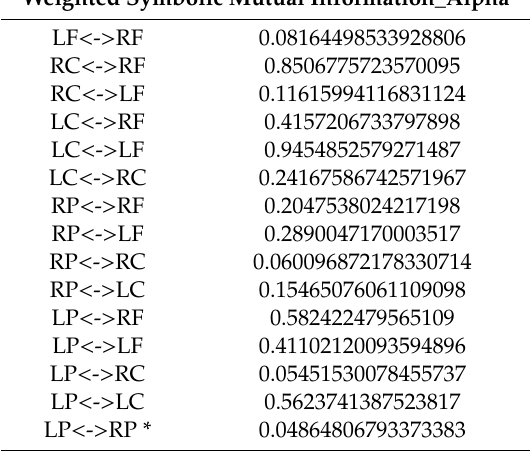
Table A2. p -Values Obtained for the Weighted Symbolic Mutual Information Connectivity Analysis in the Alpha Band. * indicates significance.